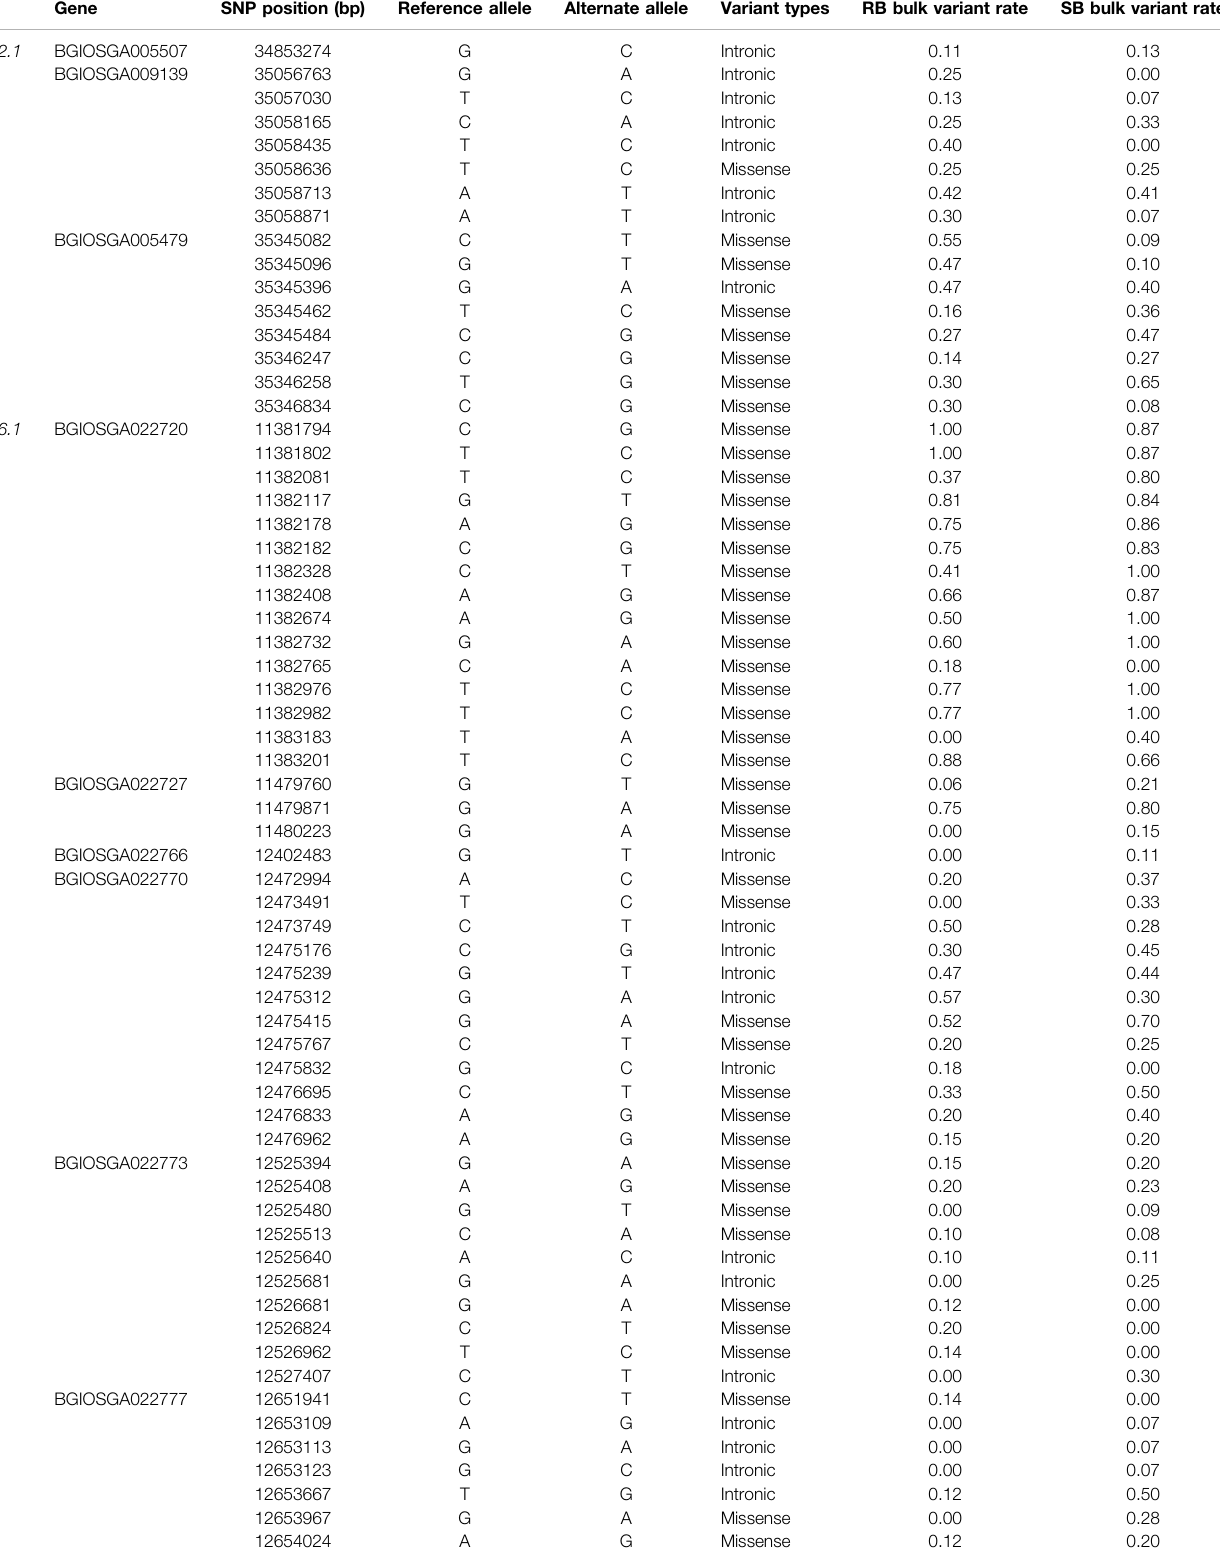
TABLE 6 | Identi fi cation of non-synonymous SNPs in candidate genes present in putative genomic regions associated with rice root-knot nematode resistance. QTL